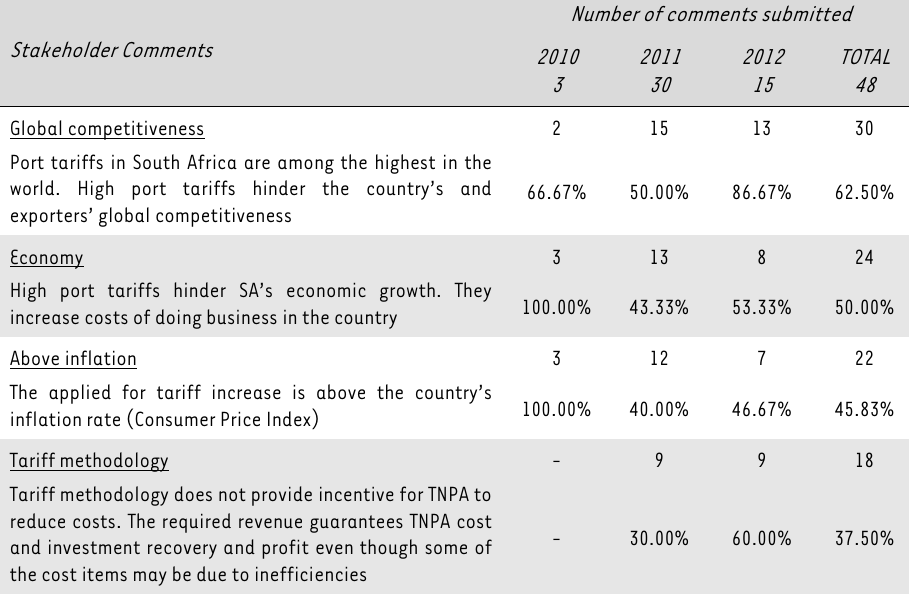
Stakeholder Comments on Port Pricing in South Africa, 2010 to 2012 tariff